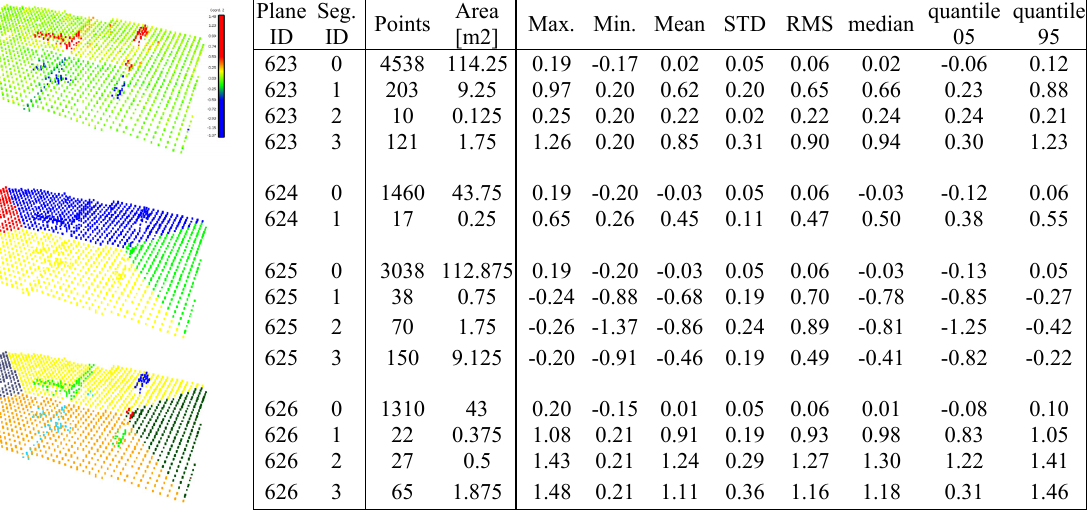
Figure 5. The quality assessment of Table 5. The quality assessment of individual building model, statistical parameters for